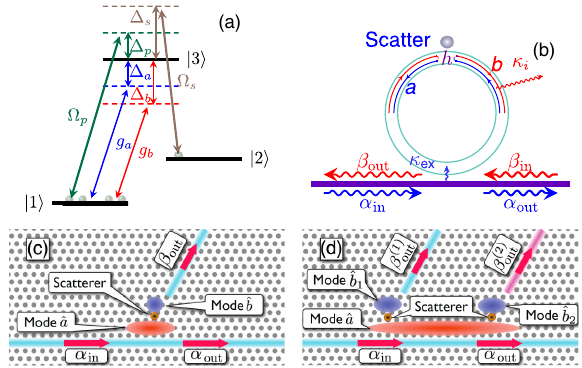
FIG. 1. Control of switching and routing via a (cid:1) -type qubit interacting with a cavity. By controlling the three-level system, we can alter the transmission of the combined qubit-cavity system. (a) Energy level diagram of a (cid:1) -type three-level scat- terer. Two cavity modes ^ a and j 3 i with strength and detuning f g tively. The classical field (cid:3) ( j 2 i $ j 3 i ) with detuning (cid:2)